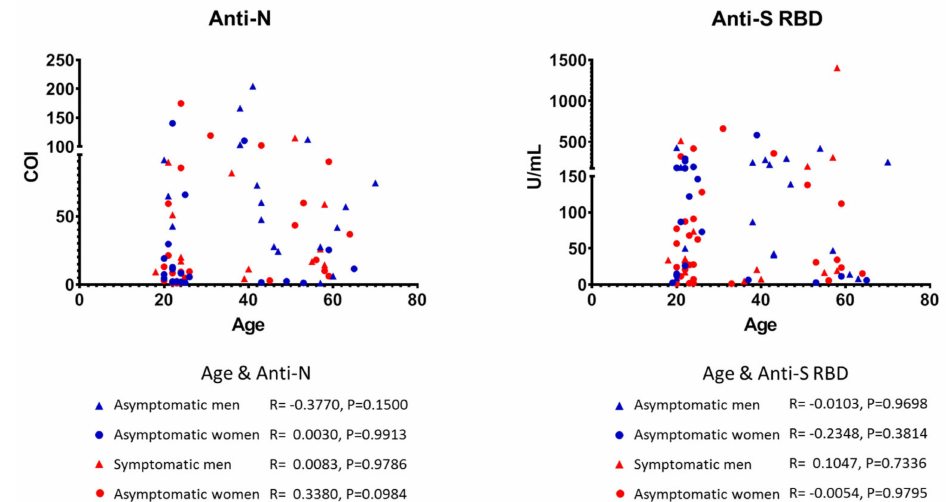
Figure 3. Scatter plots of SARS-CoV-2 anti-N (left) and anti-S RBD (right) antibody plasma levels of the participants from the National and Kapodistrian University of Athens (NKUA) with asymptomatic (blue symbols) and symptomatic (red symbols) SARS-CoV-2 infection stratified by gender (triangles, men; circles, women). Each symbol represents values (COI or U/mL) from a single participant (Spearman